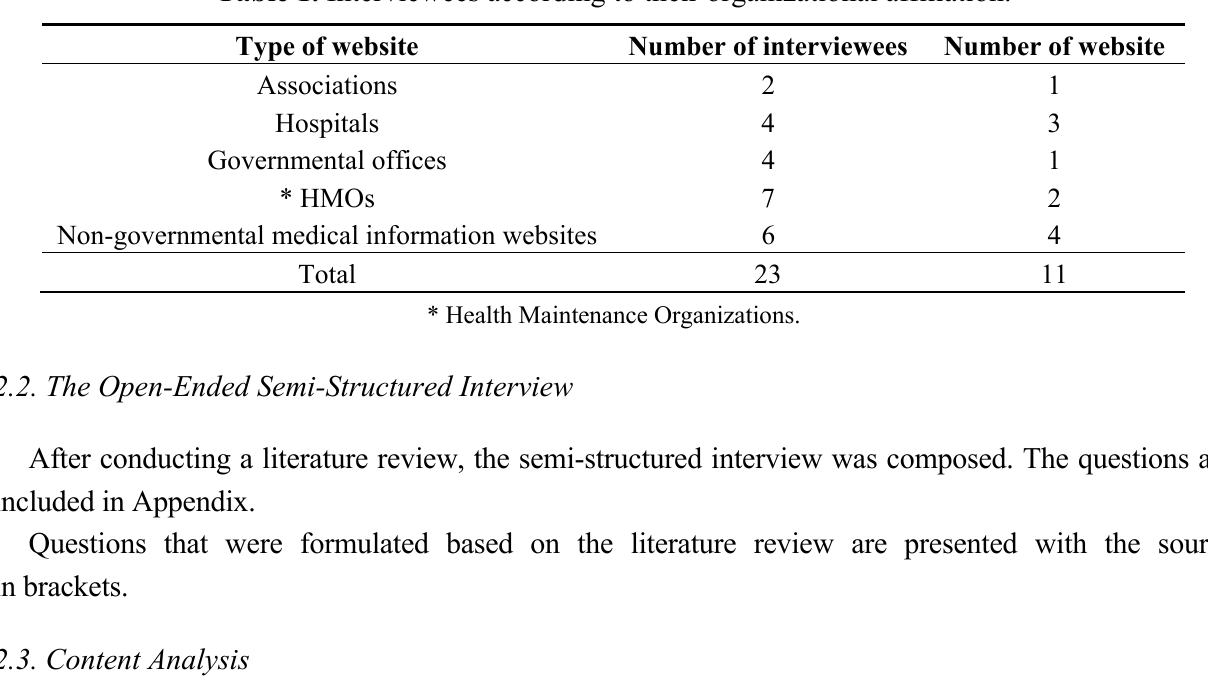
Table 1. Interviewees according to their organizational